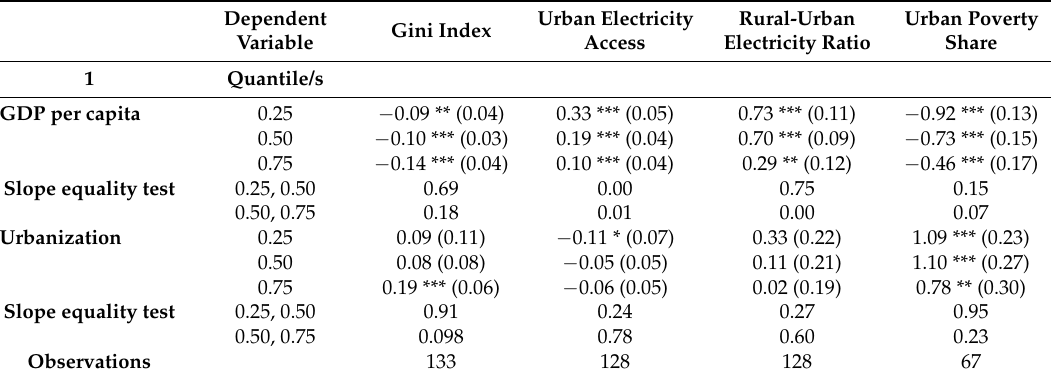
Table 4. Cross-sectional quantile regressions of the effects of GDP per capita and urbanization on select urban poverty indicators and rural-urban poverty